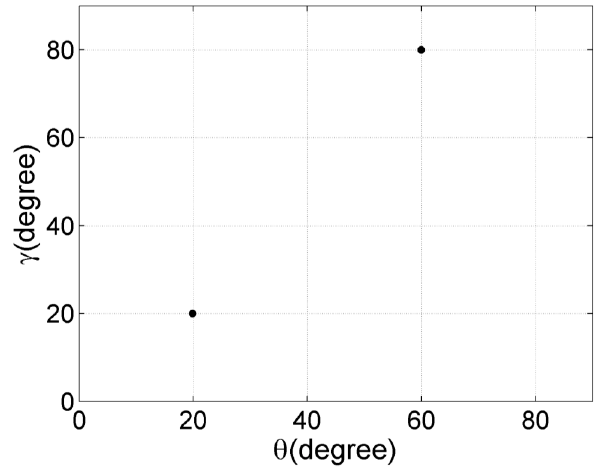
Figure 2. The 2D central DOA estimation results of the proposed algorithm (30 trials).